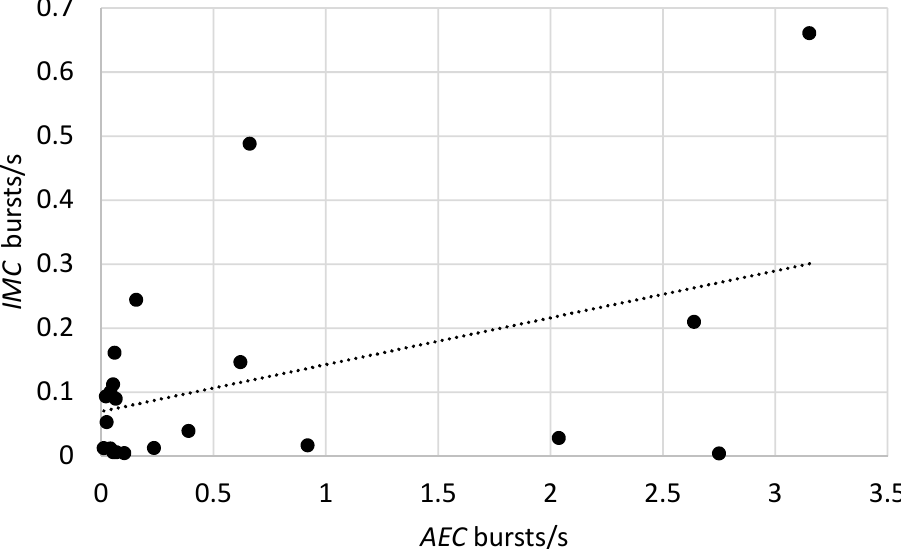
Figure 4. Comparison of insect sound burst rates from 21 bags at the Kiganjo, Nairobi, Nakuru, and Sagana warehouses in which recordings were obtained from both the IMC and AEC acoustic system. Filled circles indicate IMC system burst rates from individual bags with specified AEC system burst rates. Dotted line indicates the linear regression of IMC rates on AEC rates.